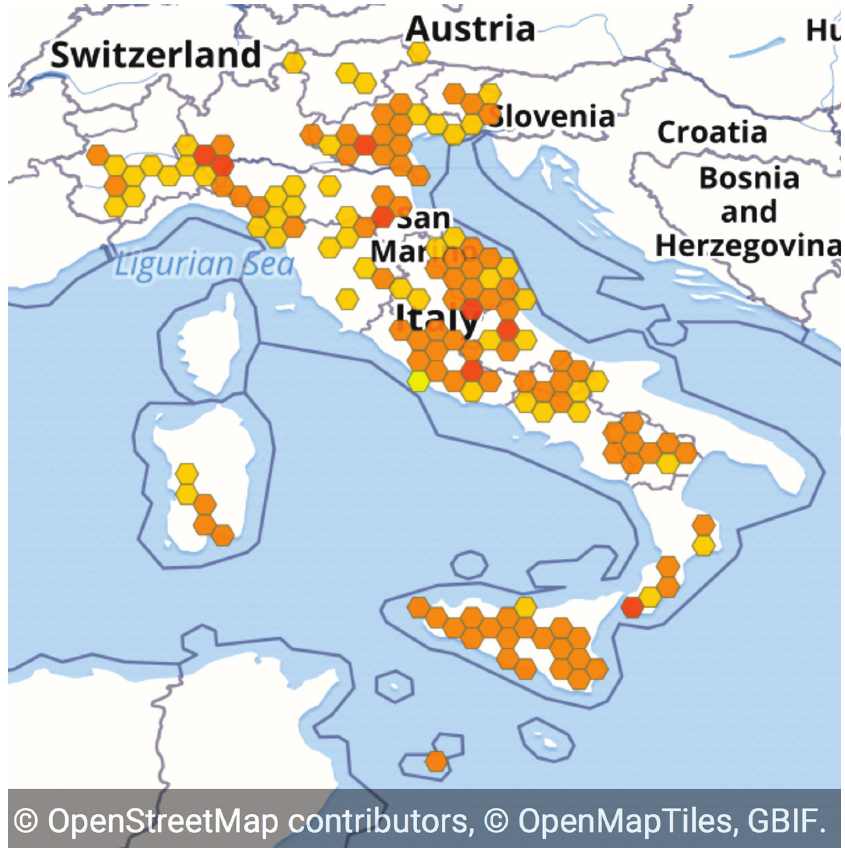
Figure 1. Geographical coverage of the “Segetal flora of Italy” dataset. Different colours express the dif- ferent number of records per cell (darker colours = higher number of